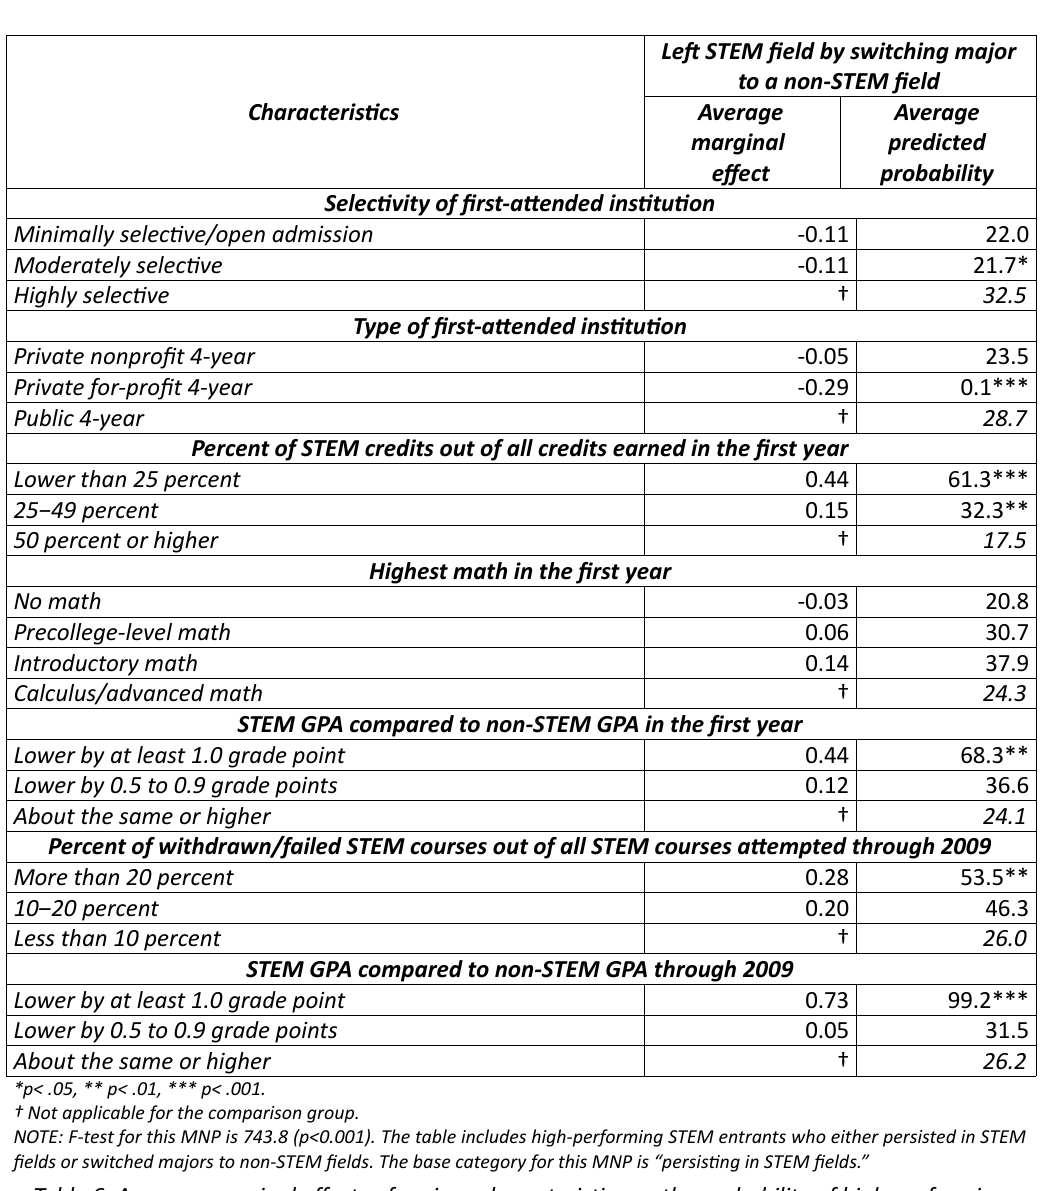
Table 6. Average marginal efects of various characteristcs on the probability of high-performing STEM entrants switching majors to a non-STEM feld, and the average predicted probability of switching majors among various groups of